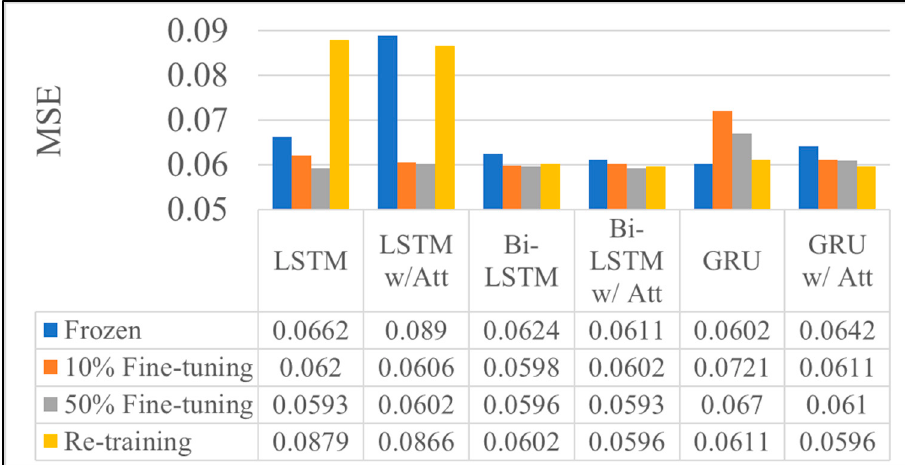
Figure 15. MSE of the target disease course prediction of TL-CDC without attention mechanism under k = 2.